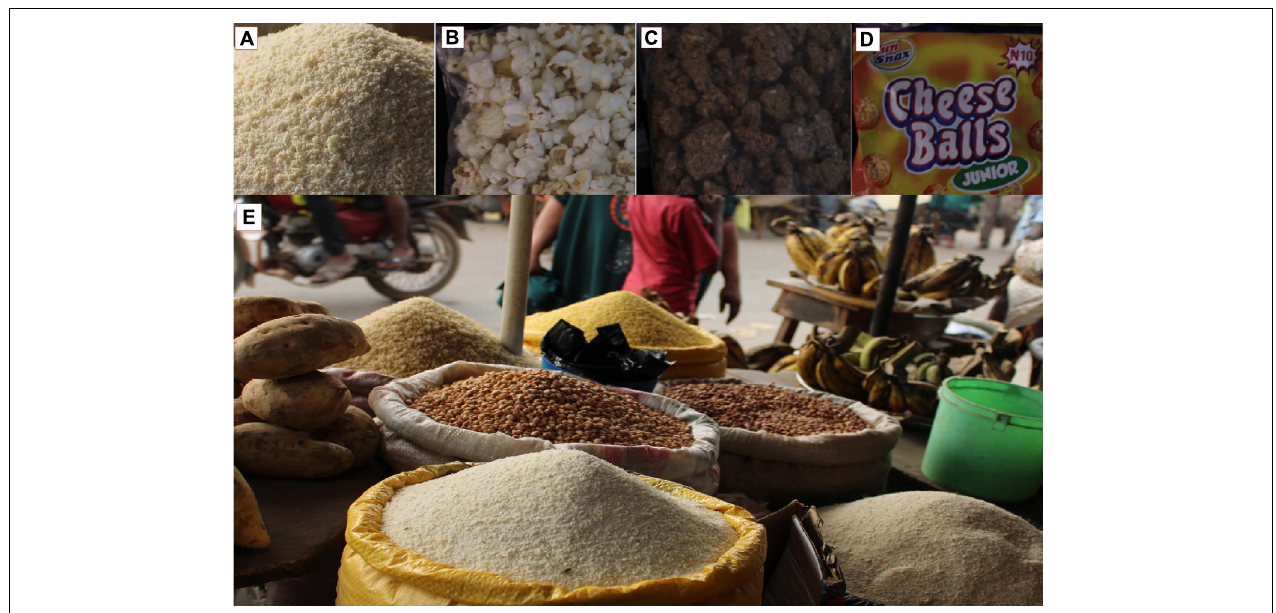
FIGURE 1 | Pictorial representation of dried ready-to-eat foods (A) garri ; (B) popcorn; (C) : granola ; (D) : cheese balls vended in markets (E) market scene) in Ogun State,